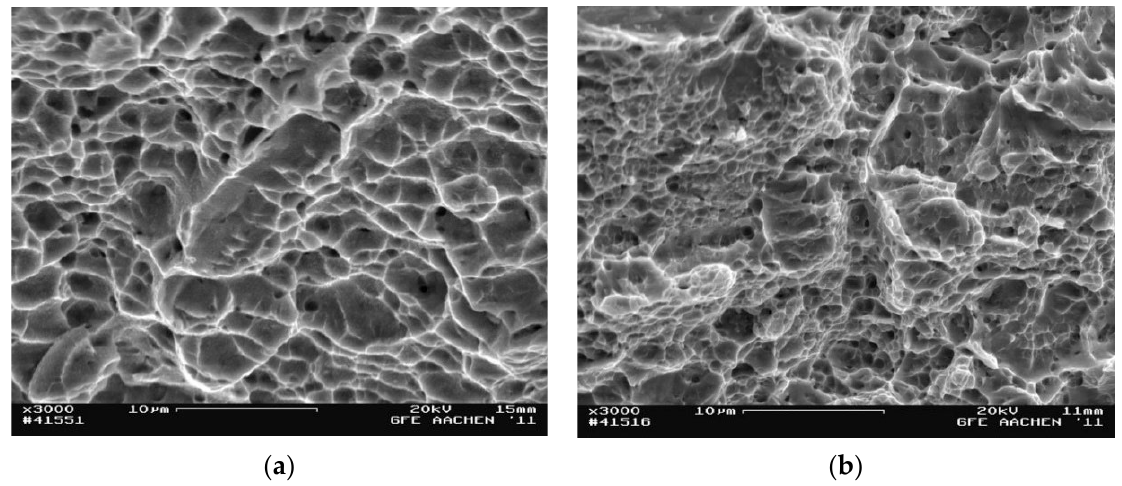
Figure 6. Fractography of the fracture surface in the crack growth zone: ( a ) at cryogenic temperature; ( b ) at room temperature.